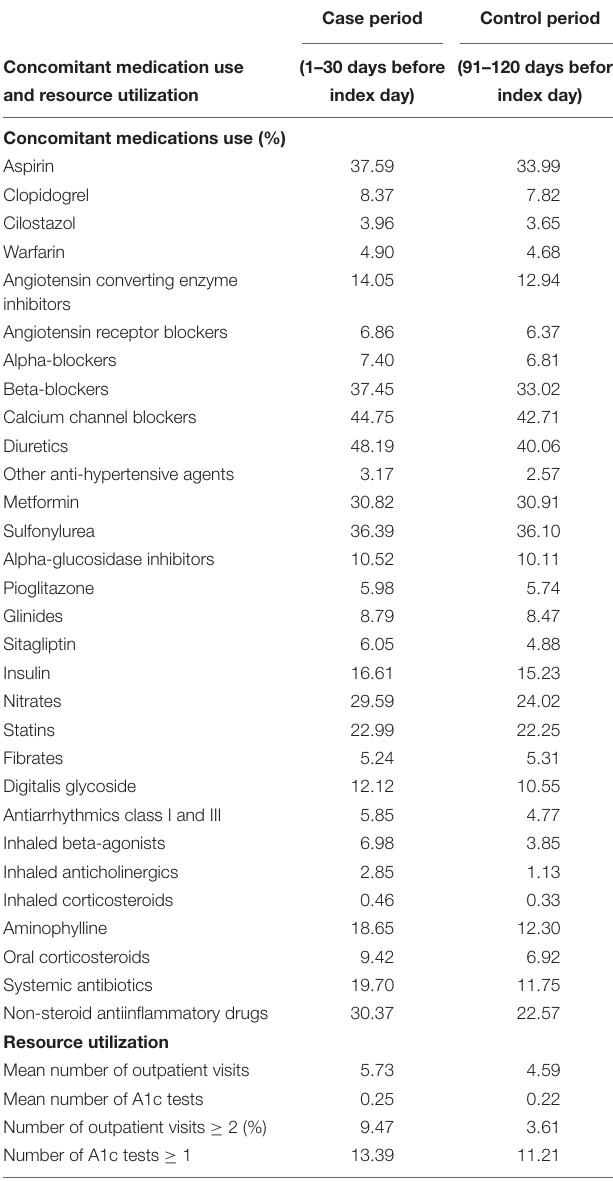
TABLE 2 | Proportion of patients with concomitant medications use and resource utilization during 1–30 and 91–120 days before hospitalization for congestive heart failure ( N =